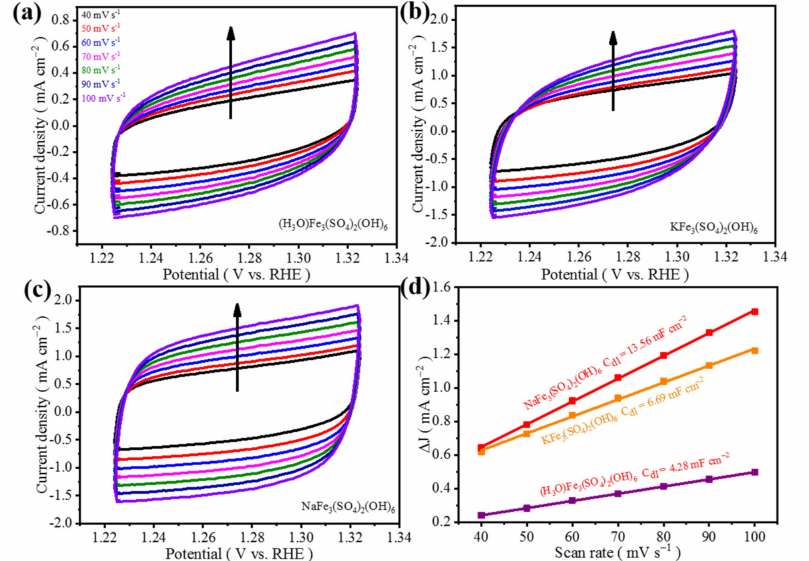
Figure 7. CV curves of ( a ) NH 4 -Fe 3 @KB-1, ( b ) NH 4 -Fe 3 @KB-2, and ( c ) NH 4 -Fe 3 @KB-3 at different